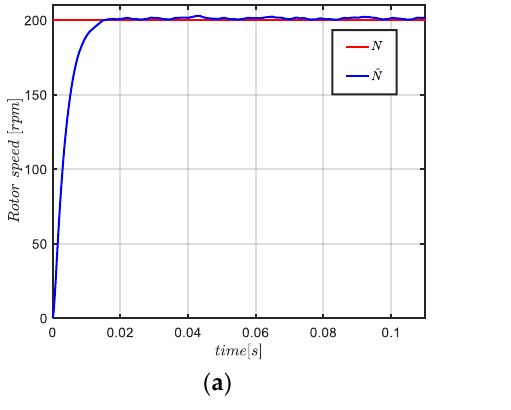
Figure 19. Three fictitious machines and associated groups of harmonics of a five-phase PMSM. As shown in Figure 19, the five-phase PMSM is decomposed to three fictitious ma- chines (MM, SM, and HM). The torque produced by MM is created by the 1st harmonic, and the torque produced by SM is created by the 3rd harmonic. The fictitious machine HM is not considered with a star connection. For this five-phase machine, the base speed is around 750 rpm for a DC power supply limit set at 48 V. For sensorless control of the five-phase PMSM, two rotation angles are required for the vector control: m  , to control MM, and